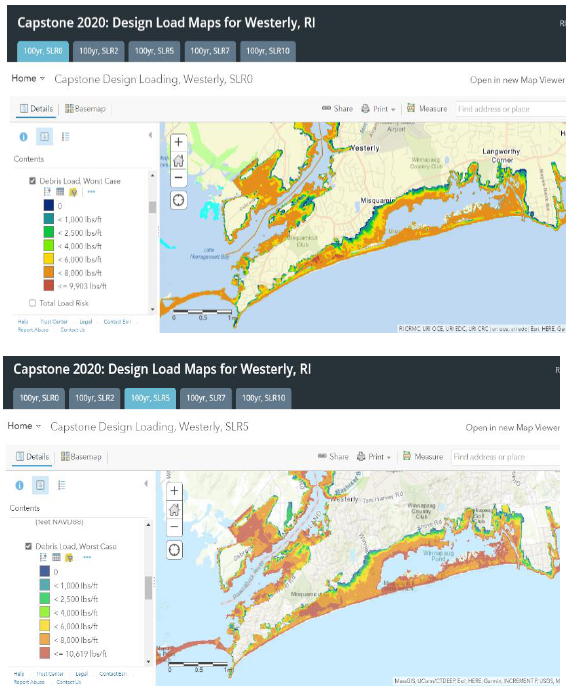
Figure 12. Worst case debris loads (lbs/ft), 100 yr storm, no sea level rise (SLR) ( upper panel) and 5 ft SLR ( lower panel).